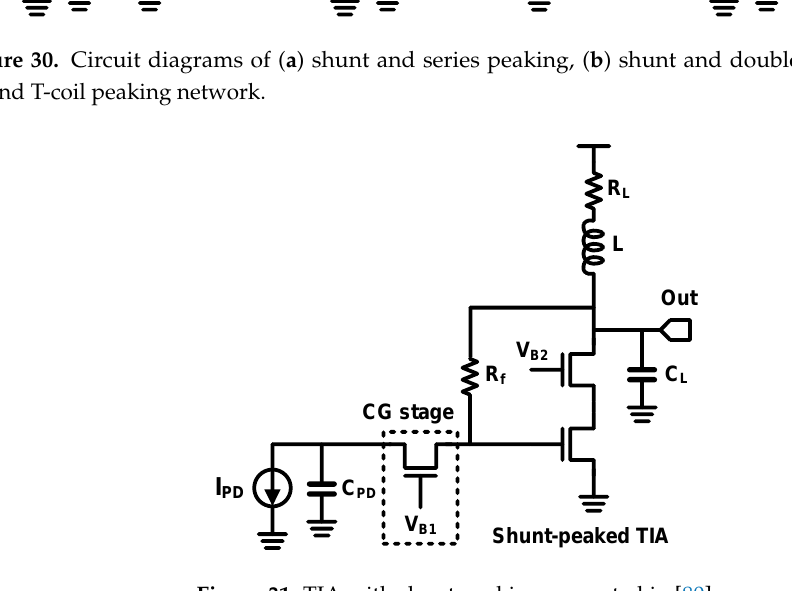
Figure 31. TIA with shunt peaking presented in [80].